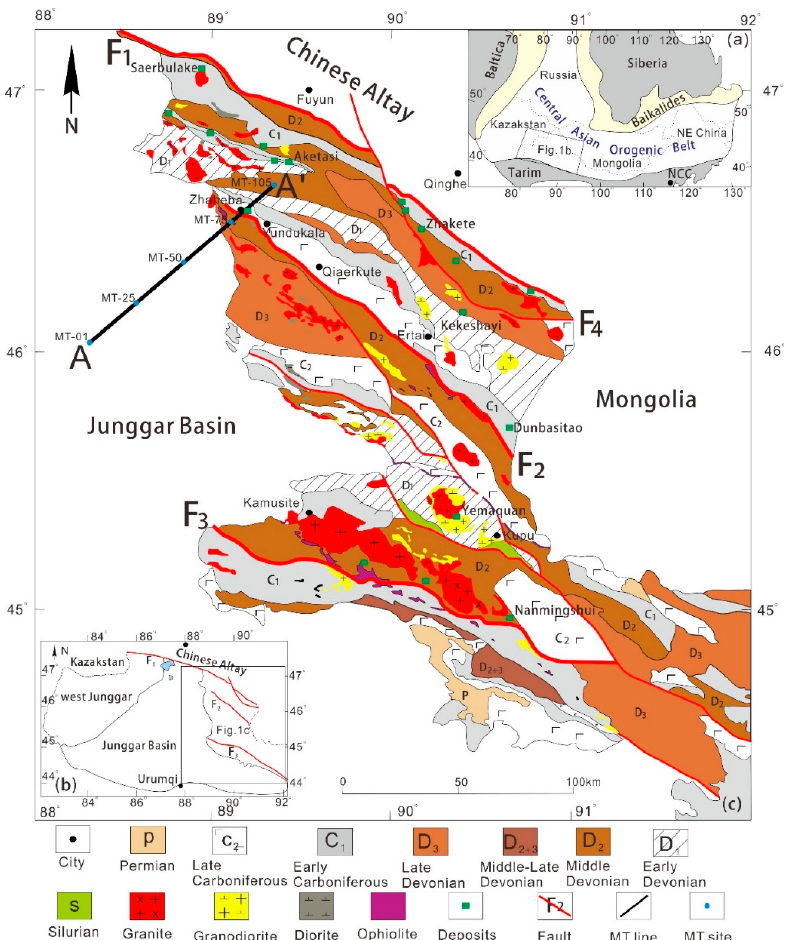
Figure 1. ( a ) Location of the Junggar terrains in the Central Asian Orogenic Belt. ( b ) Distribution of the West Junggar, Junggar Basin, and East Junggar. ( c ) Geological map of the East Junggar showing MT line locations. F1: the Erqis Fault, F2: the Zhaheba-Armantai Fault, F3: the Kelameili Fault, F4: Fuyun Fault (modified from [23]).